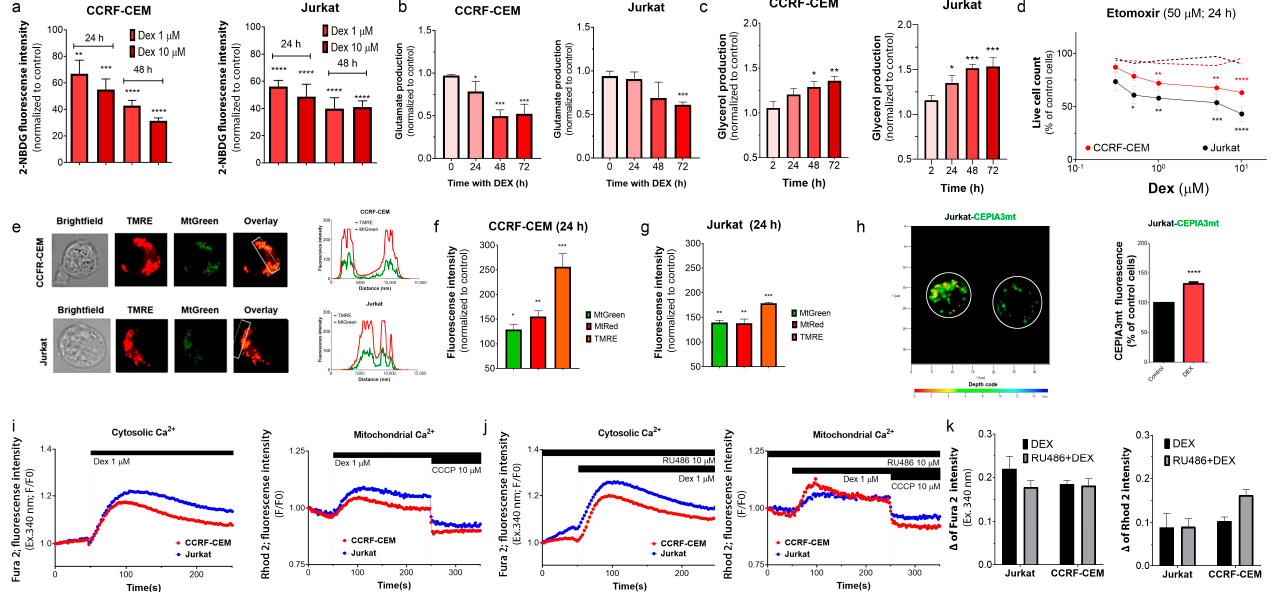
Figure 3. Dex-induced metabolic reprogramming of T-ALL cells. ( a ) Fluorometric analysis of 2-NDBG uptake in T-ALL cells exposed to Dex (1 µM, 24-48 h). An independent t-test was performed for each condition. ( b ) Glutamate production was measured through luminometry of T-ALL cells exposed to Dex (1 µM, 24-72 h). A one-way ANOVA test was employed. ( c ) Glycerol production was measured through luminometry of T-ALL cells exposed to Dex (1 µM, 24-72 h). A one-way ANOVA test was employed. ( d ) Effect of various concentrations of Dex alone or combined with etomoxir (50 µM) on live cell count in CCFR-CEM and Jurkat cells after 24 h of incubation with drugs. For Dex alone, data are redrawn from Figure 1a,b (dashed lines). For each timepoint, multiple t-tests were employed to compare control with treated groups. ( e ) Representative micrographs of T-ALL cells co-stained with TMRE and Mt Green are shown with phase contrast, TMRE, and MtGreen fluorescence and their overlay, respectively. The fluorescent profiles shown at the right were extracted from the selected sections (white rectangles) of stained cells. ( f , g ) Retention of different mitochondrial indicators by CCFR-CEM ( e ) and Jurkat ( f ) cells exposed to Dex (1 µM, 24). ( h ) Representative micrograph of Jurkat cells, transfected with the mitochondrial Ca 2+ -sensitive protein CEPIA3mt (left). Effect of Dex (1 µM, 24 h) on the fluorescence of CEPIA3mt in Jurkat cells (right). For ( f – h ), a t-test was performed. One hundred cells were analyzed in each experiment for each condition. ( i ) Changes of cytosolic free (left) and mitochondrial (right) Ca 2+ levels in CCFR-CEM and Jurkat cells in response to Dex (1 µM). ( j ) The same as in ( h ), but in the presence of the GR antagonist Ru486 (20 min preincubation). ( k ) Ru486 did not affect the intracellular Ca 2+ response to Dex. Δ Ca 2 in the ordinate is the difference between peak response and basal Ca 2+ level. An independent t-test was performed for each condition. In ( a – d , f – k ), raw data are mean ± S.E. for at least 3 independent experiments. * p <0.05; ** p <0.01; *** p < 0.001; **** p < 0.0001.